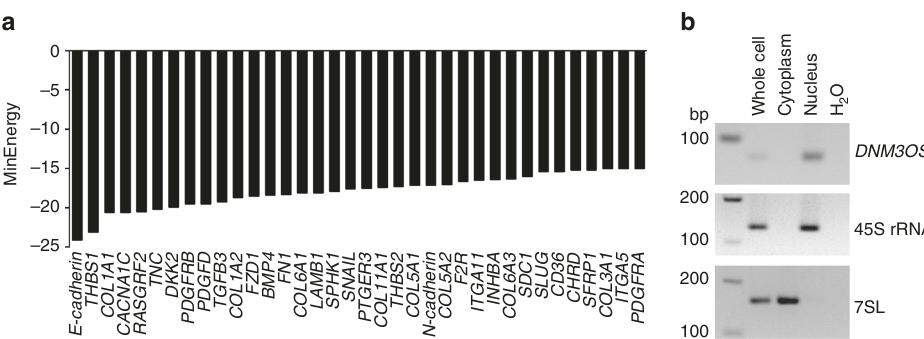
Fig. 5 DNM3OS is a potential regulator of ovarian cancer EMT genes. a Interactions between EMT-linked genes and DNM3OS predicted by sequence complementarity and a minimum energy (MinEnergy) score ≤ − 15 kcal/mol. b Subcellular fractionation of RNA followed by RT-PCR (representative of